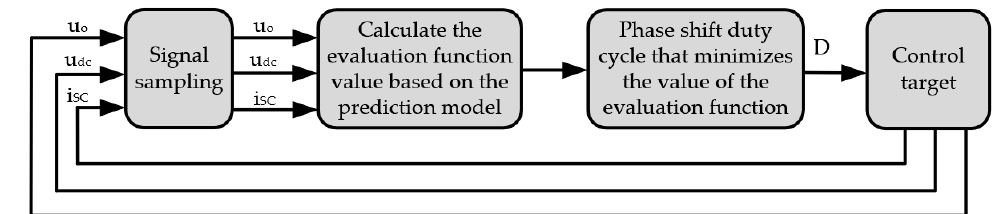
Figure 4. Schematic diagram of the MPC strategy.